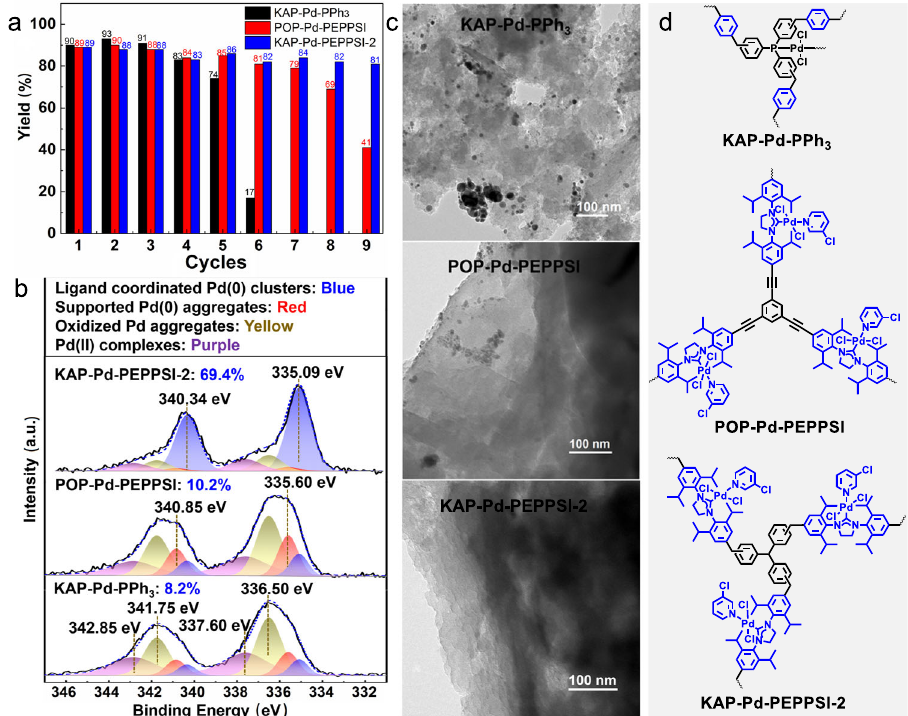
Fig. 3 Recyclability of the selected catalyst. a Recyclability of the supported Pd complex precatalysts in fl uorocarbonylation of indole. Reaction conditions: 1a (0.25 mmol), CsF (1 mmol), catalyst (5 mol%), I 2 (0.5 mmol), base (0.5 mmol), DMF (2 mL), 80 °C, 24 h, 2.0 MPa. b Pd XPS spectra and c TEM images of different catalysts after being used for fi ve times. d Structures of the catalysts used